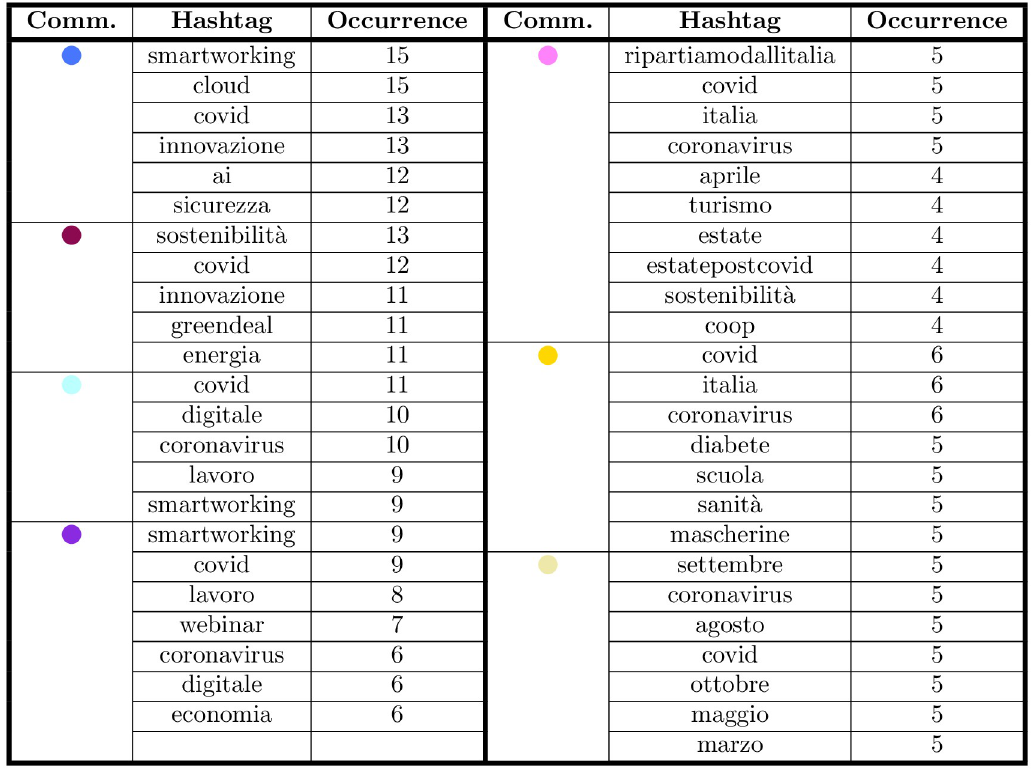
Fig 8. The top 5 frequent hashtags for the communities in the largest connected component of Fig 2. Due to the great number of ex aequo , the top 5 most frequent hashtags is, in general, longer than 5.